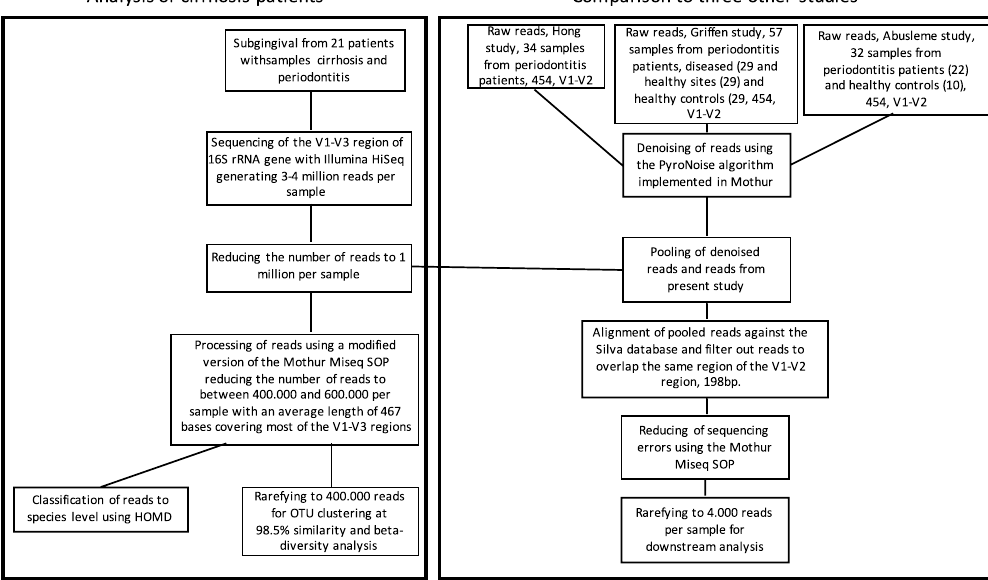
Figure 1. Flowchart summarizing the processing of the reads from the cirrhosis patients and the comparison with reads of downloaded datasets from the Griffen study 35 , the Hong study 37 and the Abusleme study 36